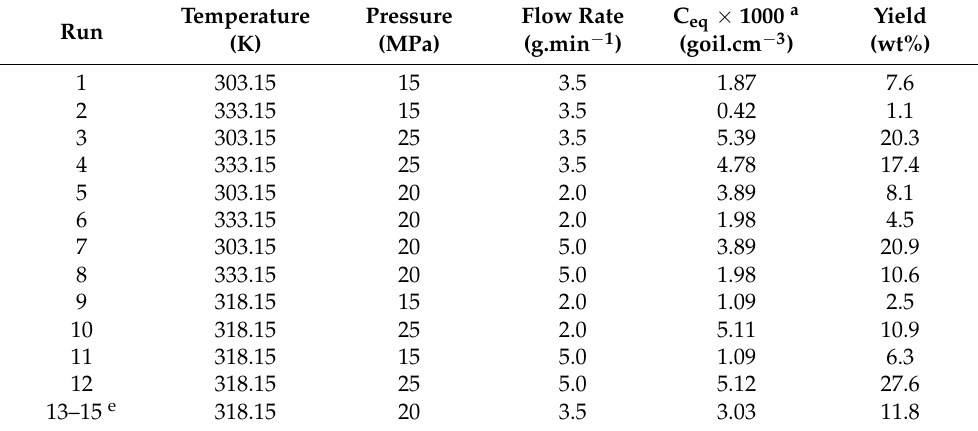
Table 3. Experimental conditions, extraction yield results, and parameters of the mathematical model for pequi oil extraction using supercritical CO 2